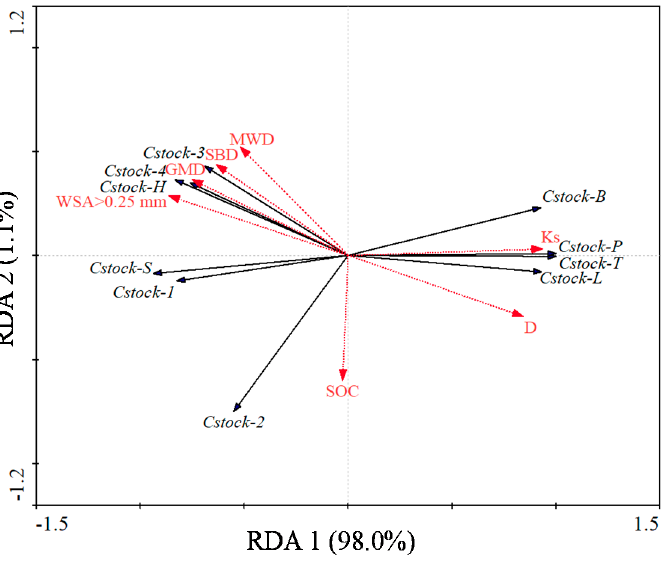
Figure 7. The sorting of correlations between carbon stocks and soil properties. C stock-1 , C stock-2 , C stock-3 , and C stock-4 represent carbon stocks in the 0–20 cm, 20–40 cm, 40–60 cm, and 60–80 cm soil layers, respectively; C stock-S , plant system carbon stock; C stock-P , plant system carbon stock; C stock-T , carbon stock of trees; C stock-L , carbon stock of litter; C stock-B , carbon stock of shrubs; C stock-H , carbon stock of herbs. Table 2. Stepwise multivariate regression analysis of the SOC stocks at different depths.